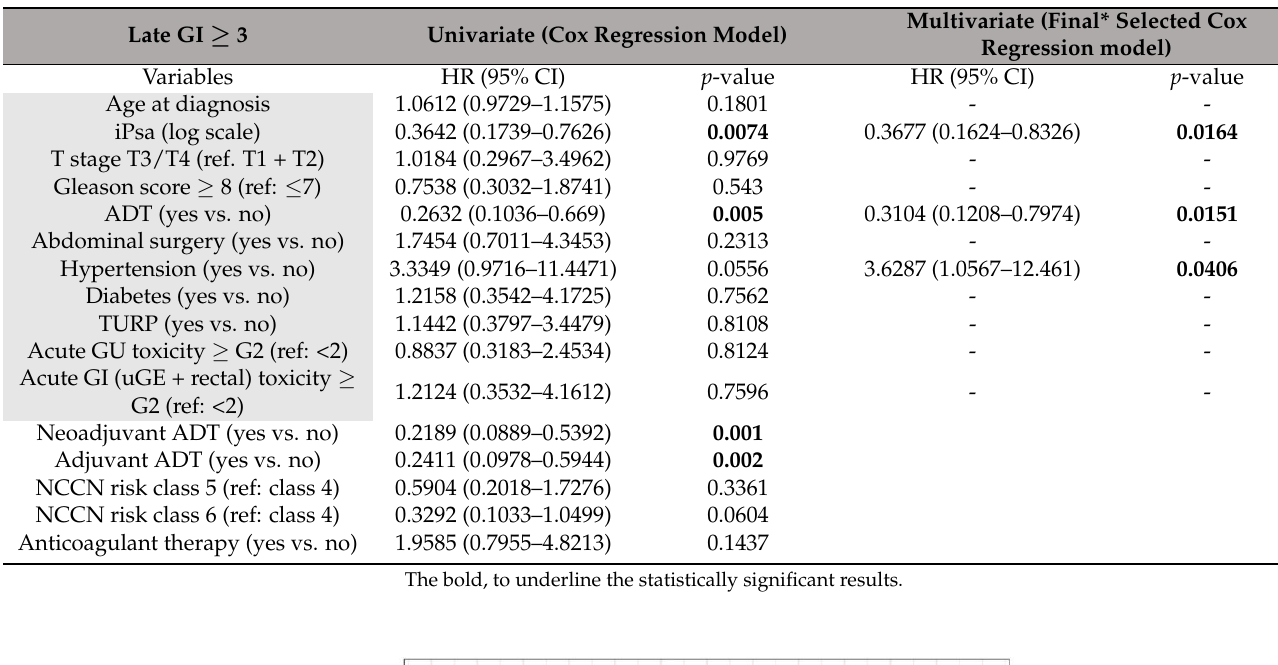
Figure 4. Kaplan–Meier estimate of time to late GI ≥ G3. Although all the data were used for statis- tical analyses, here, for graphic purposes only, the plot was curtailed at 12 years. 4. Discussion